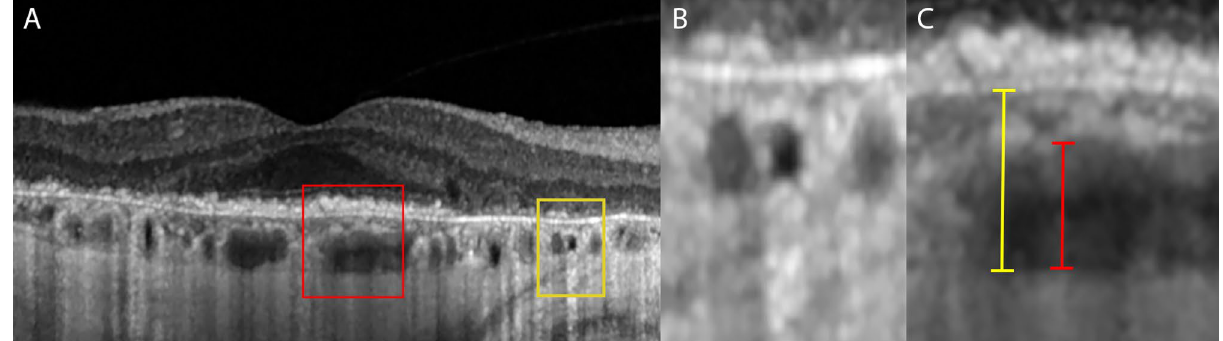
Figure 3. ( A ) Choroidal cavern visible on structural OCT, together with examples of choroidal thickness measurements. ( B ) Detail of the yellow box: choroidal cavern visible as a non-reflective, round structure with a typical hypertransmission tail. ( C ) Detail of the red box: Sattler layer-choriocapillaris complex thicknesses results from the difference between choroidal thickness (yellow marker) and Haller layer thickness (red marker).